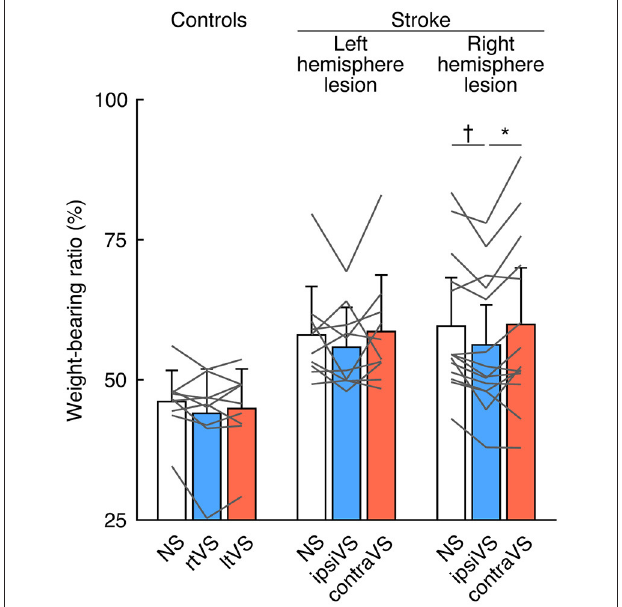
FIGURE 2 | Effects of bipolar galvanic vestibular stimulation on weight-bearing in the controls, patients with a left hemisphere lesion, and patients with a right hemisphere lesion. Each color bar indicates the mean weight-bearing ratio (WBR) during each type of bipolar galvanic vestibular stimulation (GVS). More than 50% of WBR indicates more weight-bearing on the right side (for the controls) and the ipsilesional side (for the patients with stroke). Each error bar indicates a standard deviation. Each gray line indicates changes in the WBR during each type of bipolar GVS in each participant. NS, no stimulation; rtVS, left-anodal and right-cathodal vestibular stimulation; ltVS, right-anodal and left-cathodal vestibular stimulation; ipsiVS, contralesional-anodal and ipsilesional-cathodal vestibular stimulation; contraVS, ipsilesional-anodal and contralesional-cathodal vestibular stimulation. * p < 0.05; † p < 0.01.